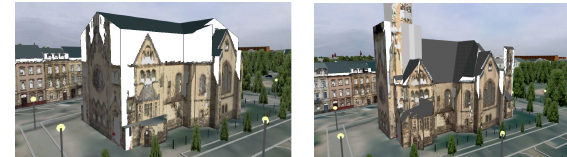
Figure 19: A projection of terrestrial colored LiDAR points onto walls within a maximum distance of three meters shows differ- ences between the existing model-driven (tower missing) and the new data-driven method. There are points missing at tower walls (grey color) because they were partially hidden from the scanner. White points mark errors.